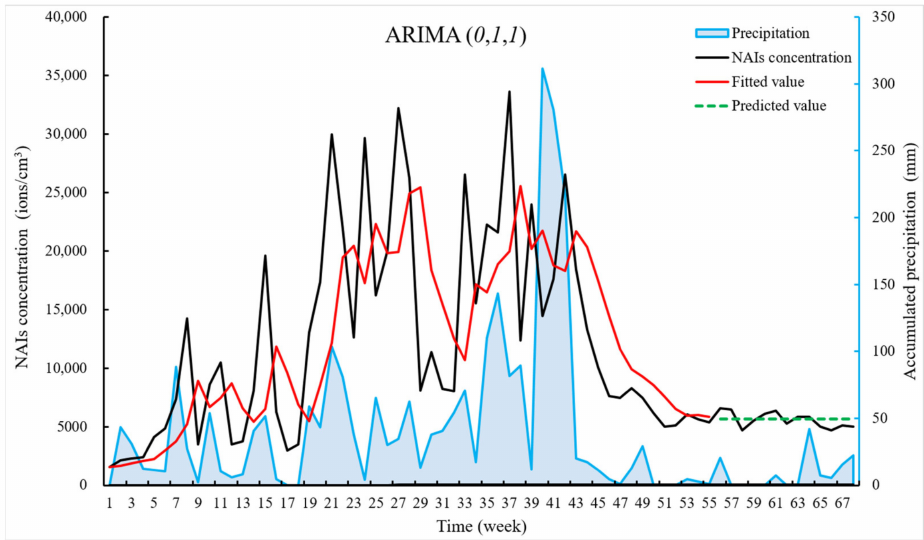
Figure 8. Time series of weekly data of NAI concentration. Week 1 to 55 was used as a time series of training data. We can see that the time series was highly fluctuating and uneven, and combined with topic 3.2, where the data did not pass the smoothness test, we made 1 difference to the series to make the series smooth, which was the red line. In the ARIMA ( 0, 1, 1 ) model time series plot, the black line represented the raw data of NAI concentrations, and the green line represented the predicted values of NAI concentrations, which were closer to the raw values. The blue line represents weekly precipitation (accumulate hourly precipitation into weekly